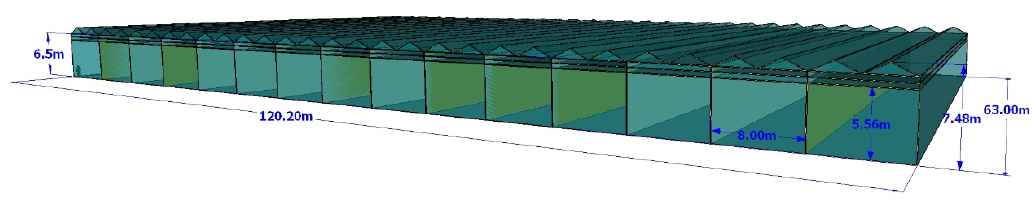
Figure 7. Three-dimensional (3-D) model of the studied multi-span greenhouse using Transys3d.